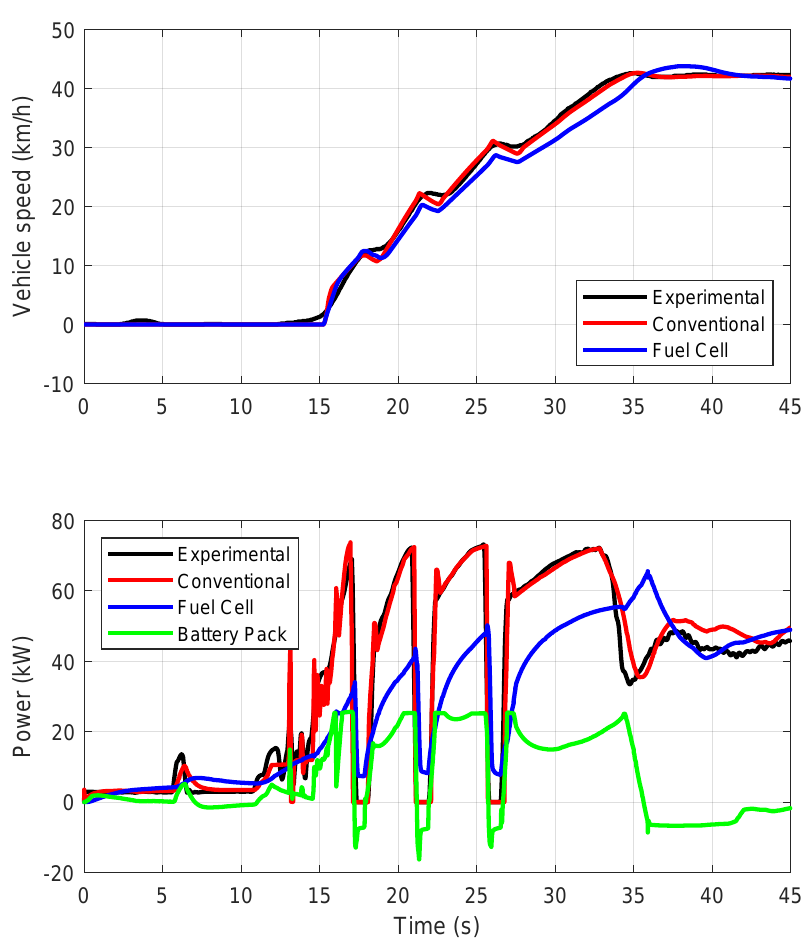
Figure 14. Acceleration test: Experimental vs. Simulations.